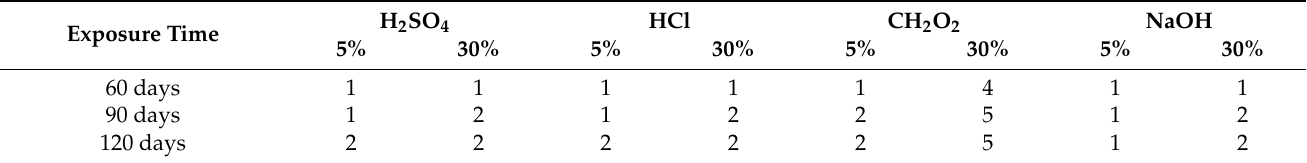
Table 7. Evaluation of the visual assessment of the chemical resistance of the NBR-GF coating.